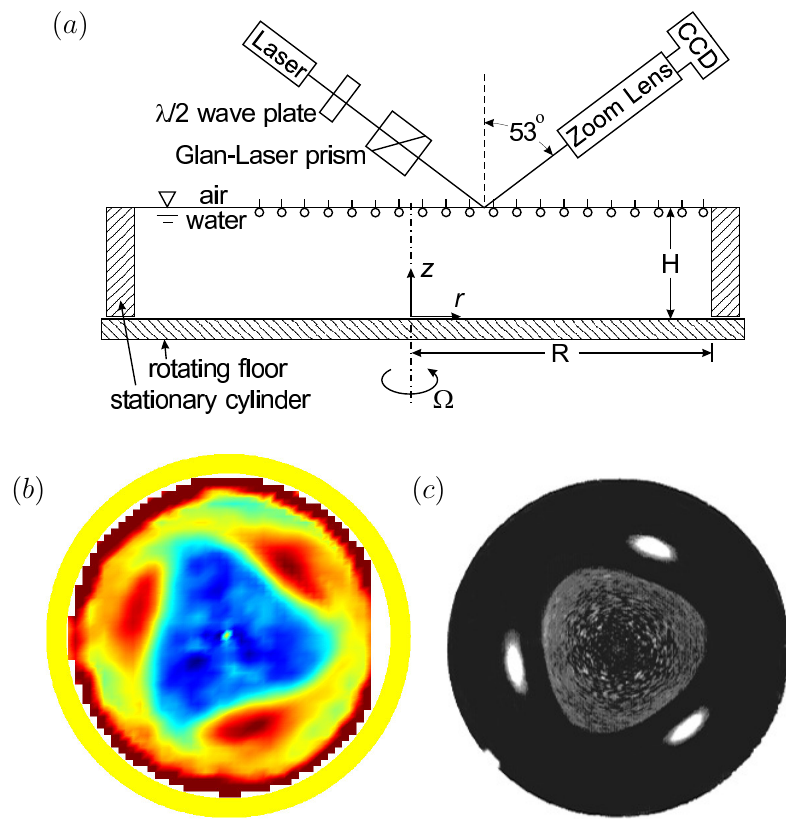
Figure 3. ( a ) Schematic of the open cylinder flow system and Brewster angle microscopy (BAM) setup (reproduced with permission from [66], published by AIP Publishing 2002), ( b ) shear stress τ r θ at the interface with a vitamin K 1 monolayer initially spread at c 0 = 0.8mg/m 2 , Reynolds number Re = Ω R 2 / ν = 2000 and H / R = 0.26 (reproduced with permission from [20], published by AIP Publishing 2003), and ( c ) surface-bound polystyrene (21 µ m) at the same Re and H / R (reproduced with permission from [21], published by American Chemical Society